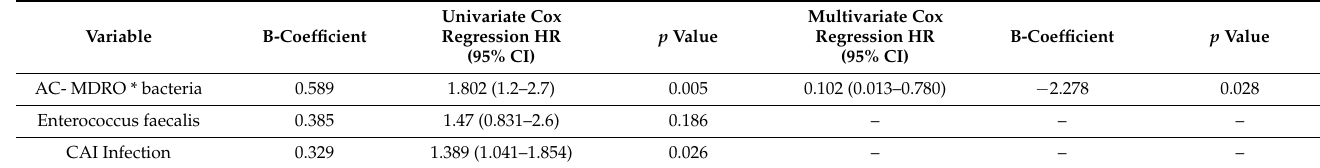
Table 6. The univariate and multivariate cox regression risk factor for ICU